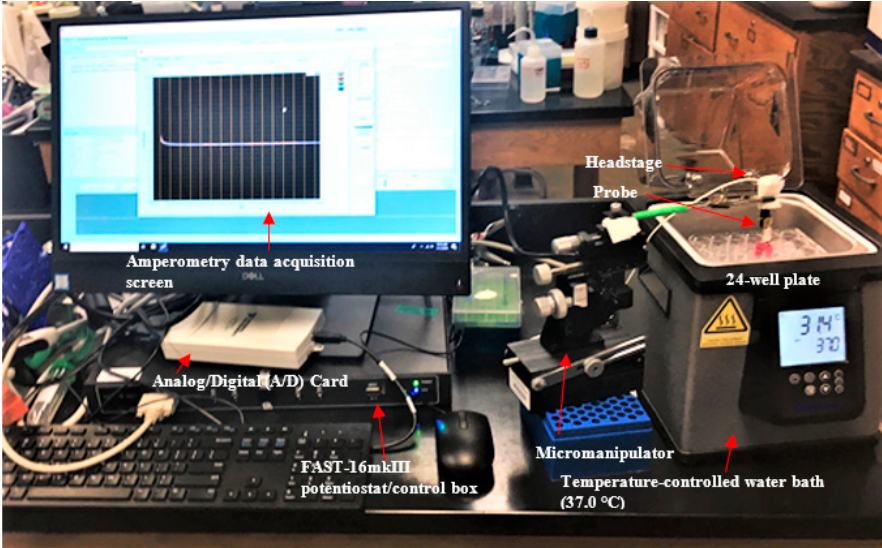
Figure 4. Setup of probe during amperometry experiments (+0.7 V vs. Ag/AgCl reference electrode). Data are recorded at a frequency of 10 Hz and displayed in real time as current (nA) vs. time (s).